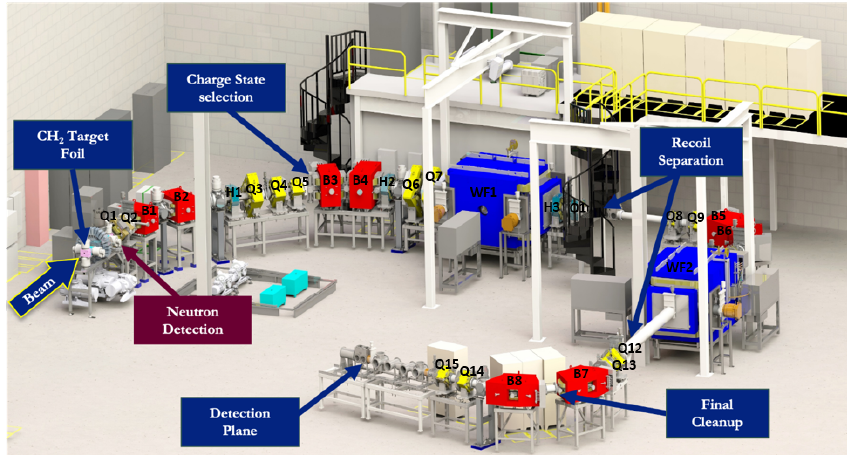
Figure 1. The SECAR layout. Beam enters SECAR at the target location, shown on the left of the picture. A neutron detection system surrounds the target. It is constituted of four liquid scintillators (EJ-301, 2x2 inch) in a ring configuration, and 21 LENDA bars (Low-Energy Neutron Detection Array) [10]. Thereafter, the consecutive sequence of dipole pairs, focusing magnetic elements, and velocity (Wien) filters follows, aiming to separate the recoils from the unreacted projectiles. Note that the Wien filters fields were not used for this measurement as the di ff erence in magnetic rigidity was deemed adequate for separation. Refer to Section 2 for a detailed description of the